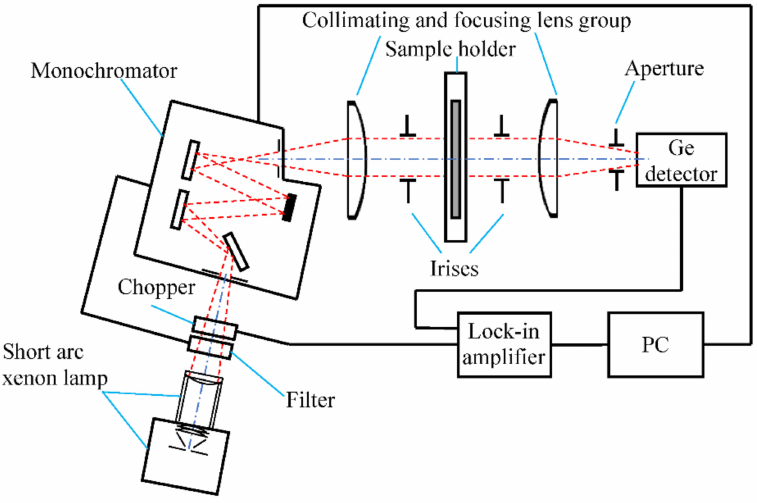
Figure 6. Schematic diagram of the normal-normal transmission measurement system